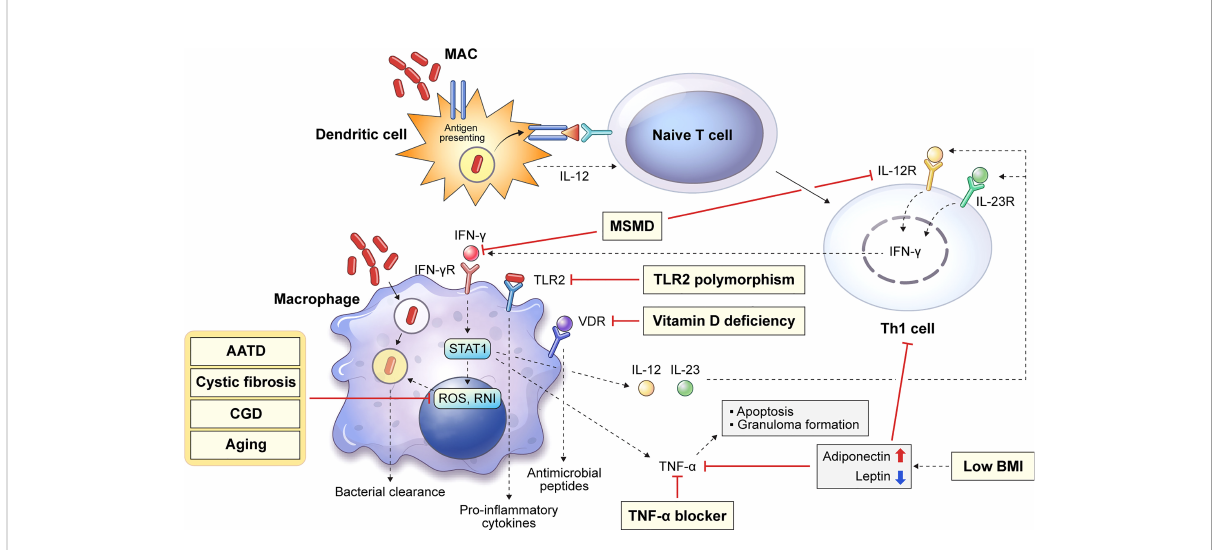
FIGURE 1 Overview of representative host innate genetic defects increasing the susceptibility to MAC infection. Host susceptibility factors to MAC infection can infer important innate immunological functions against the infection in the host. Several innate or acquired host factors can increase the susceptibility to MAC infection by suppressing the host defense, and these factors are shown in the corresponding signaling pathways (yellow box). Dendritic cells endocytose mycobacteria, which induces the presentation of antigens to naïve T cells. Antigen presentation induces the differentiation of naïve T cells into Th1 cells causing macrophage activation, which produces reactive oxygen and nitrogen species and leads to intracellular bacterial death. In addition, IFN- g and TLR2 signaling induces the production of pro-in fl ammatory cytokines, such as IL-12, IL-23, and TNF- a . Secreted IL-12 and IL-23 bind to their receptors on Th1 cells and enhance IFN- g production. TNF- a production promotes macrophage apoptosis and granuloma formation. MAC, Mycobacterium avium complex; MSMD, Mendelian susceptibility to mycobacterial disease; AATD, alpha-1 antitrypsin de fi ciency; CGD, chronic granulomatous disease; BMI, body mass index; IFN, interferon; TLR, Toll-like receptor; IL, interleukin; TNF, tumor necrosis